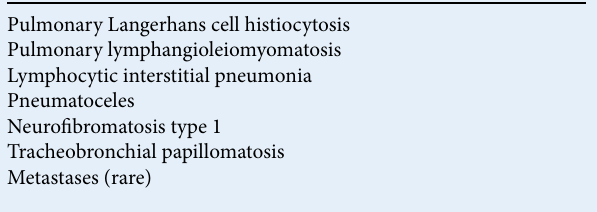
Table I. Differential considerations for multiple